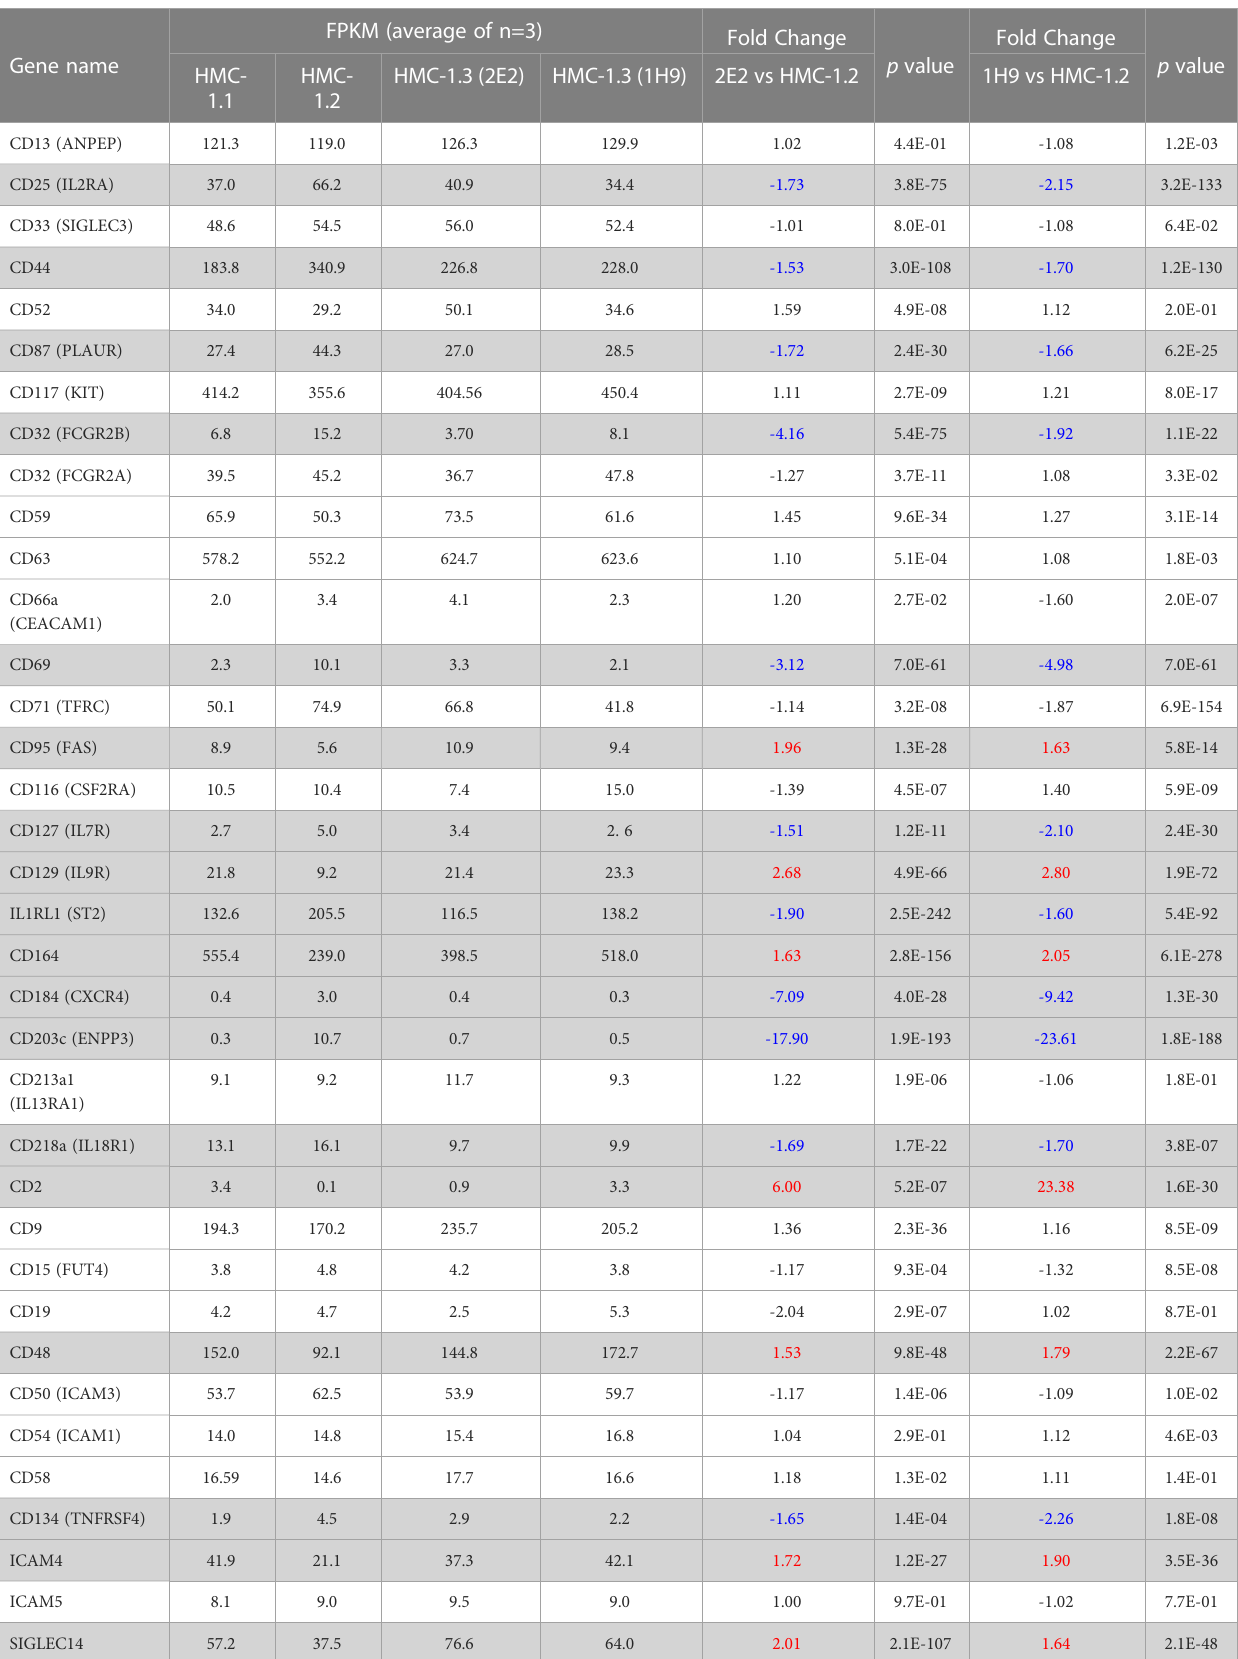
TABLE 1 Expression changes in cell surface markers, receptors, and molecular targets in HMC-1.3 compared to HMC-1.2 cells.